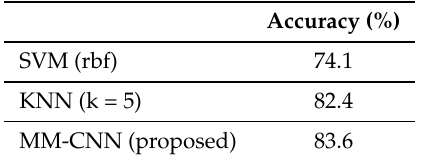
Table 3. Validation set accuracy for state-of-the-art and proposed methods.